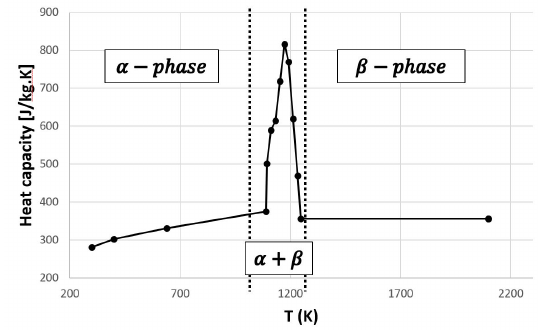
Figure 1. Heat capacity for Optimized ZIRLO™. These values are taken from Frapcon/Fraptran corre- lation, thus they are approximate.